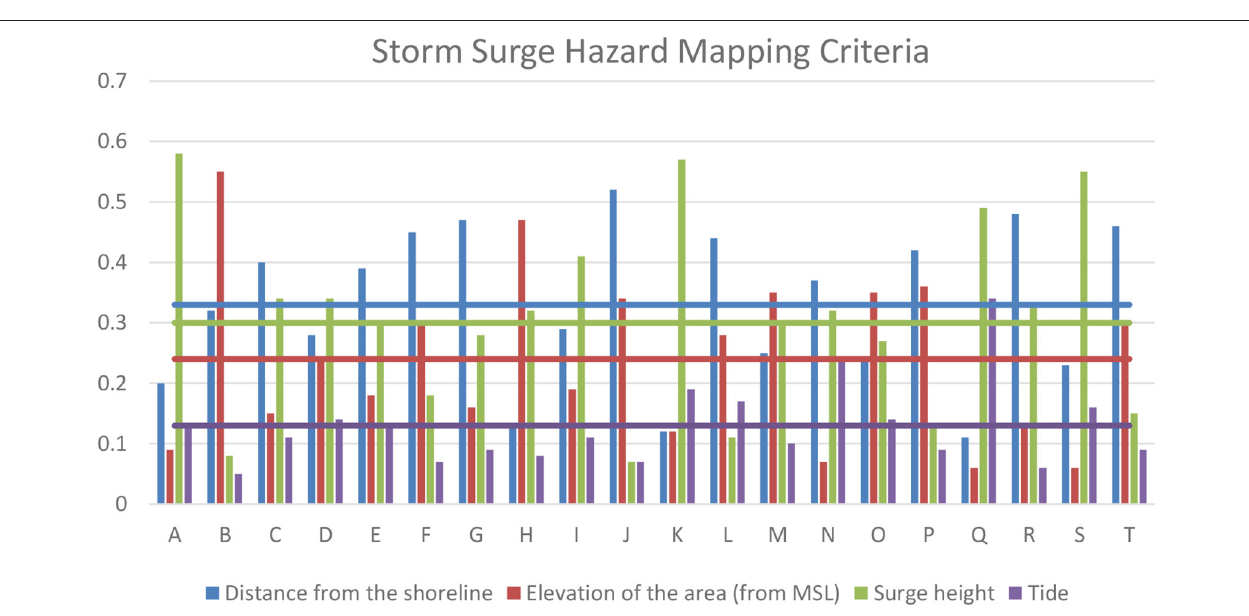
drainage network with a computed weight of 0.11, which is 4% greater than the lowest